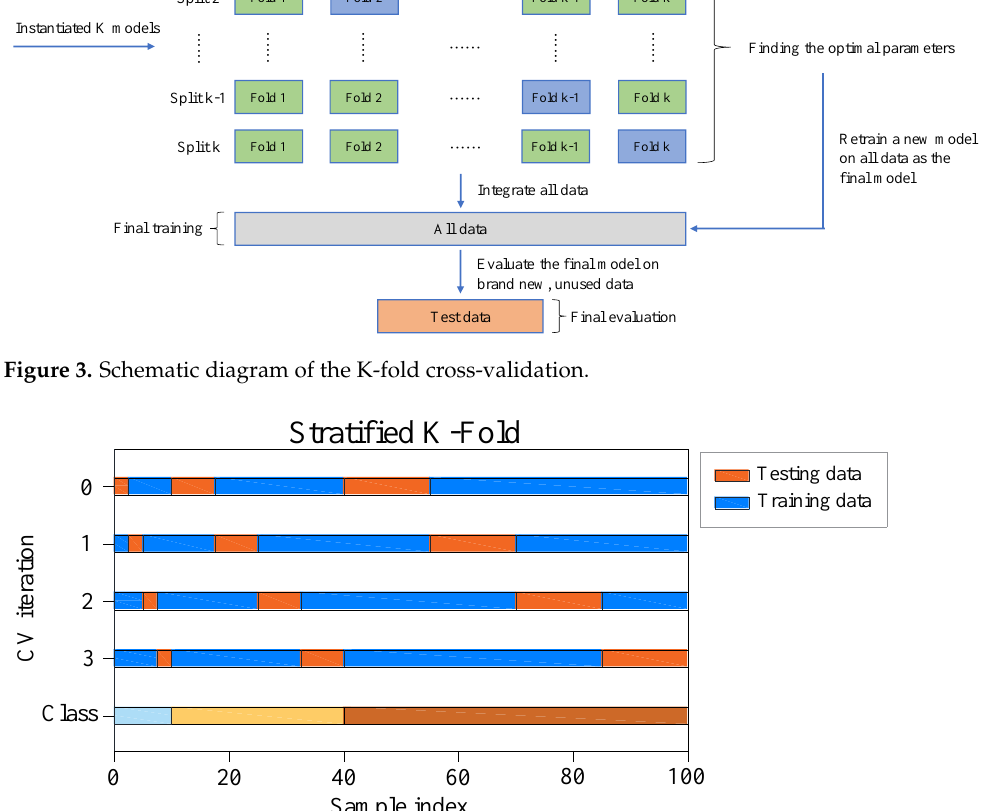
Figure 4. Schematic diagram of stratified K-fold cross-validation.